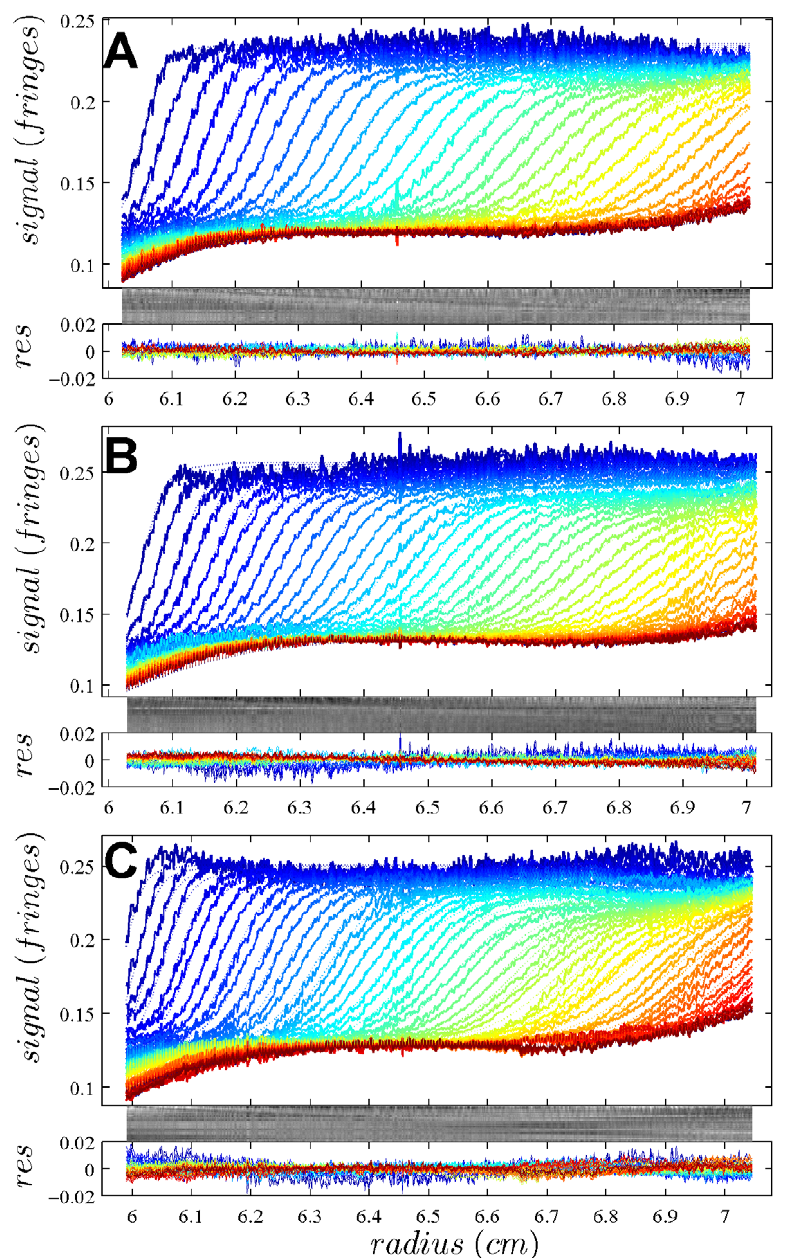
Figure 3. Interference optical data from the same sample as in Figure 1, in the same representation. Rmsd values are 0.00230 fringes (A), 0.00289 fringes (B) and 0.00312 fringes